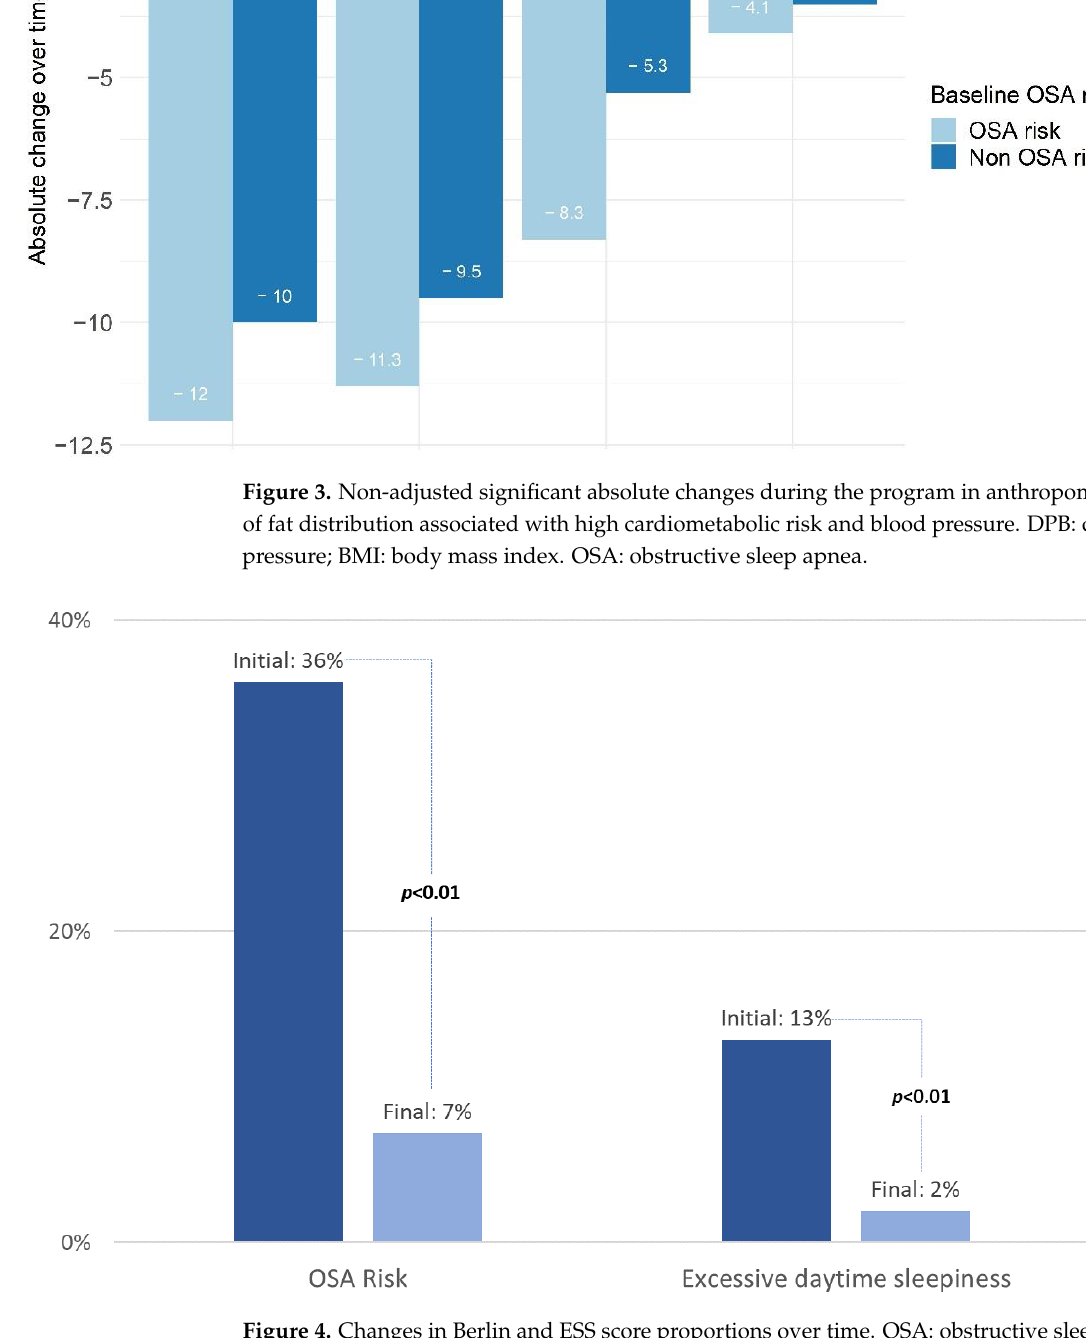
Figure 4. Changes in Berlin and ESS score proportions over time. OSA: obstructive sleep apnea. OSA risk: BERLIN score ≥ 2—Excessive daytime sleepiness: Epworth sleepiness scale ≥ 11.